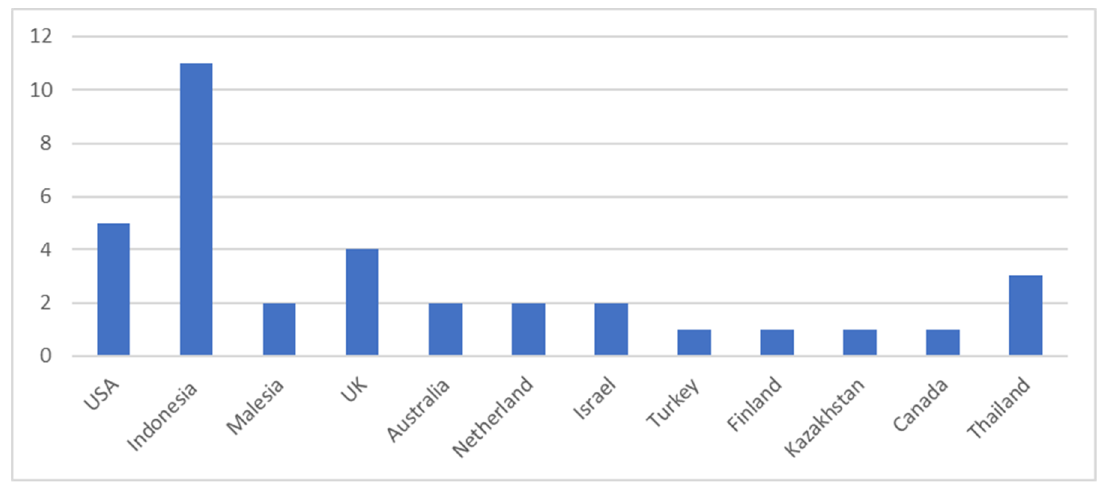
Figure 3. Geographic origins of articles.